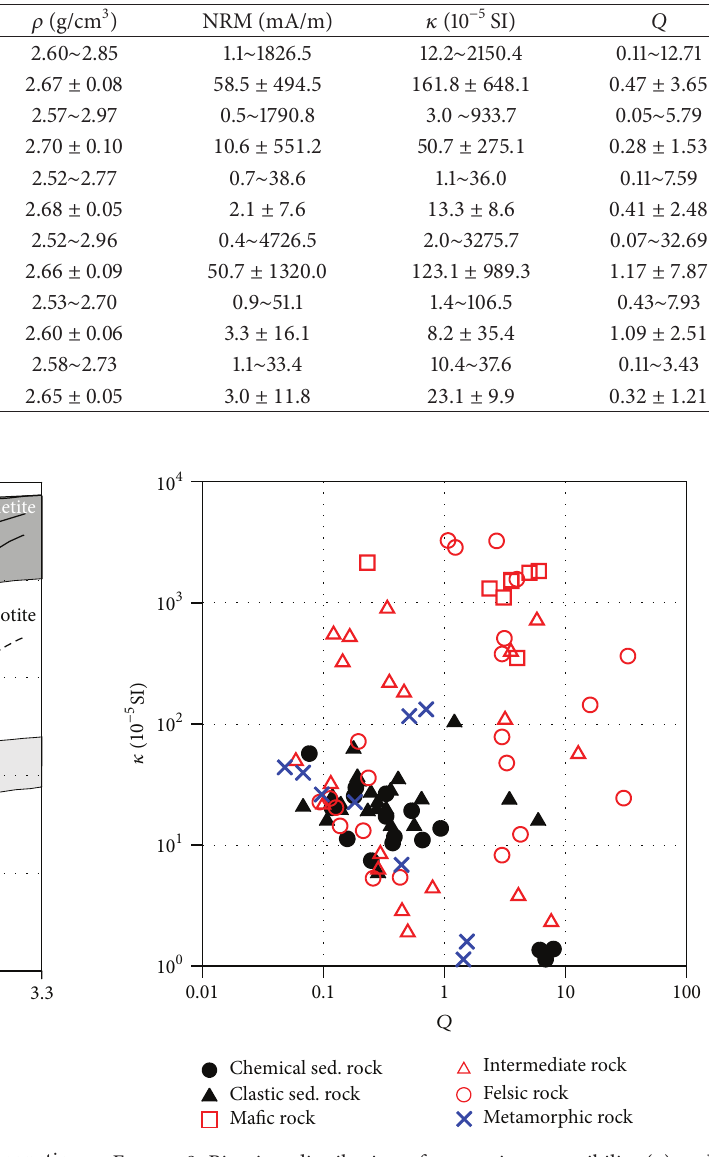
Figure 8: Bivariate distribution of magnetic susceptibility (𝜅) and K¨oenigsberger ratio (𝑄) for all samples sorted for major